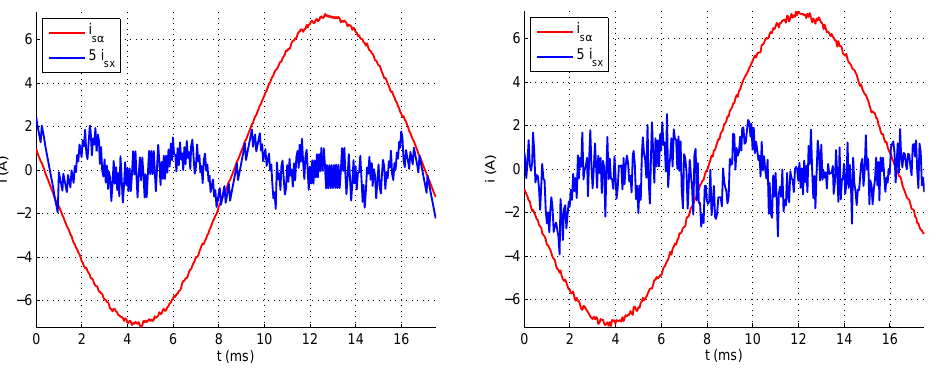
Figure 4. Experimental results for ( λ xy = 0.5, λ nc = 5 × 10 − 4 ) ( left ) and for ( λ xy = 0.5, λ nc = 15 × 10 − 4 ) ( right ).